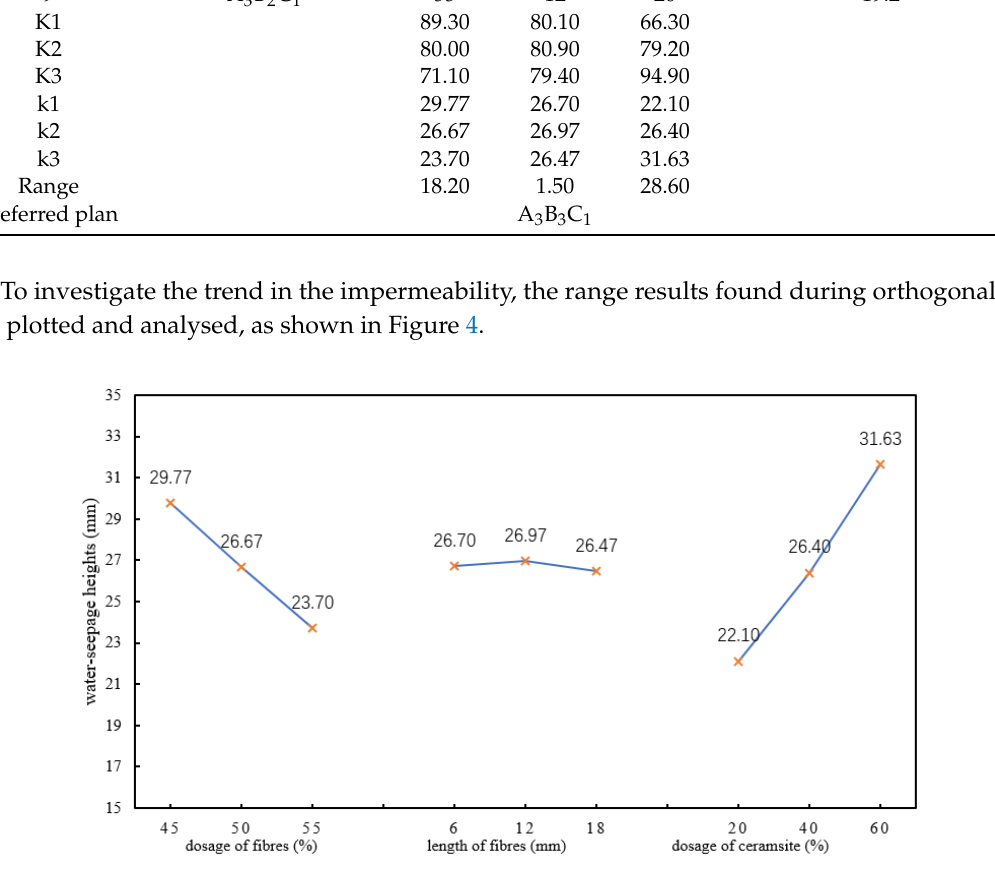
Figure 4. Trend in measured water-seepage height.